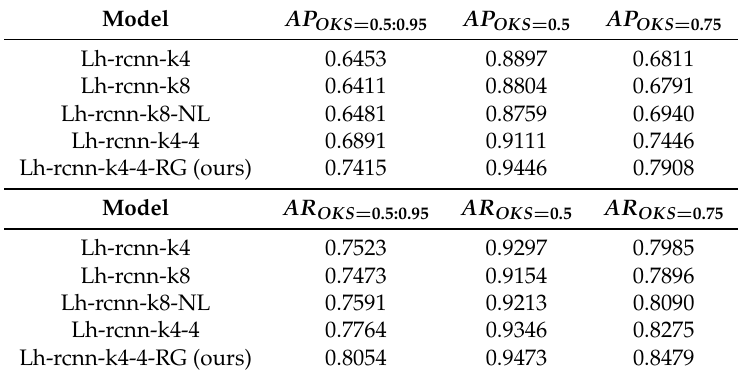
Table 3. Comparison of different keypoints head on Parrot indoor dataset. (AP and AR represent the average accuracy and average recall, respectively. OKS indicates object keypoint similarity. For the explanations of each model, please refer to the